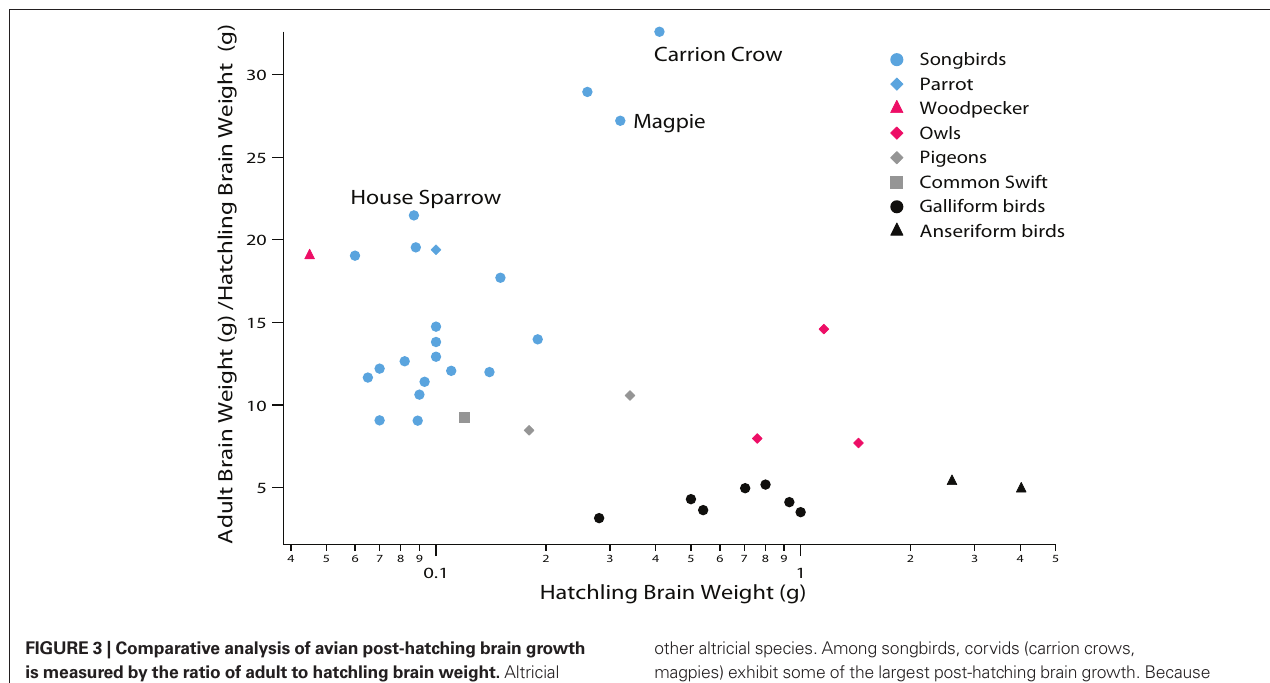
Figure 3 | Comparative analysis of avian post-hatching brain growth is measured by the ratio of adult to hatchling brain weight. Altricial species with proportionally small telencephalons (e.g., swifts and pigeons) exhibit more post-hatching brain growth than precocial species (e.g., anseriform and galliform birds). Parrots and songbirds (i.e., oscine passerines) exhibit even more post-hatching brain growth than many